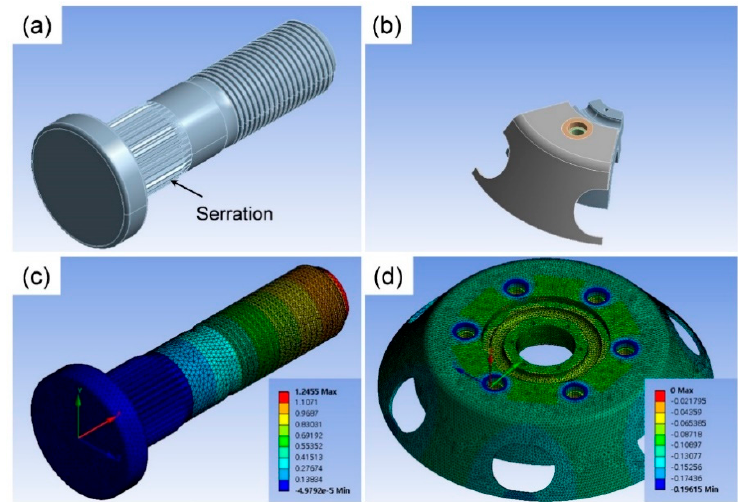
1 kN compressive force. Unit for ( c ) and ( d ) is μ